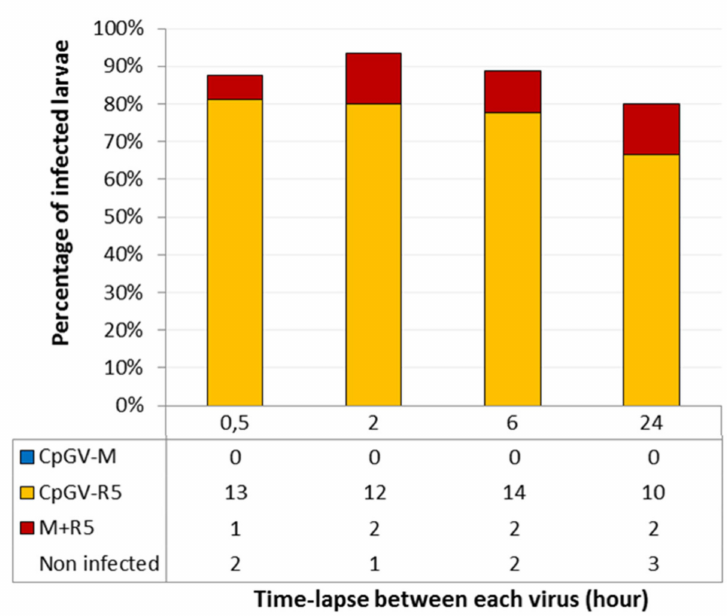
Figure 2. Infection status determined by qPCR of R GV larvae ( n ≈ 80) inoculated sequentially with CpGV-R5, then with CpGV-M, in function of the time-lapses between exposure to different genotypes